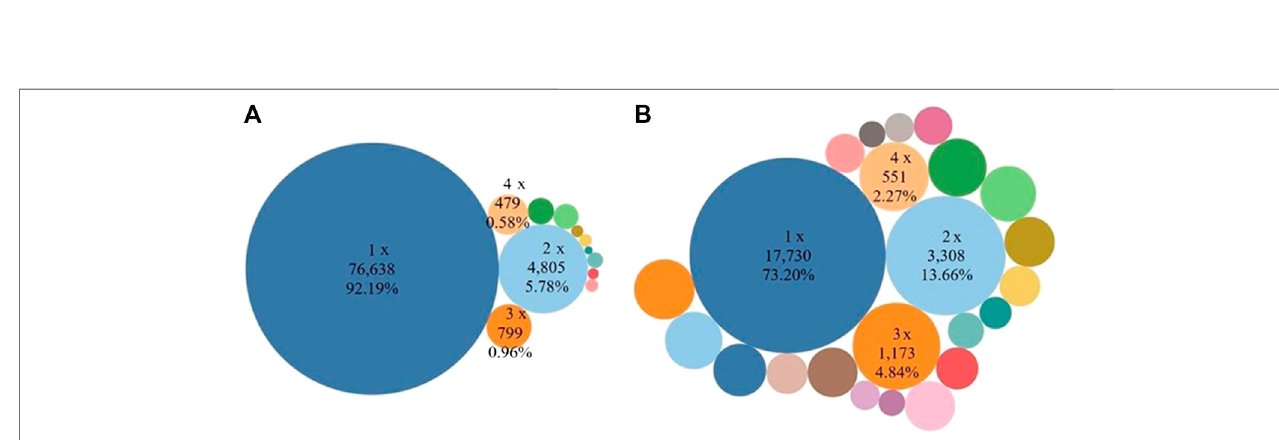
FIGURE 4 | Co-authorship and repeat collaboration in SDG-related research among (A) authors and (B) institutions, 1999 – 2018. Most SDG-related research co-authorship happened only once.